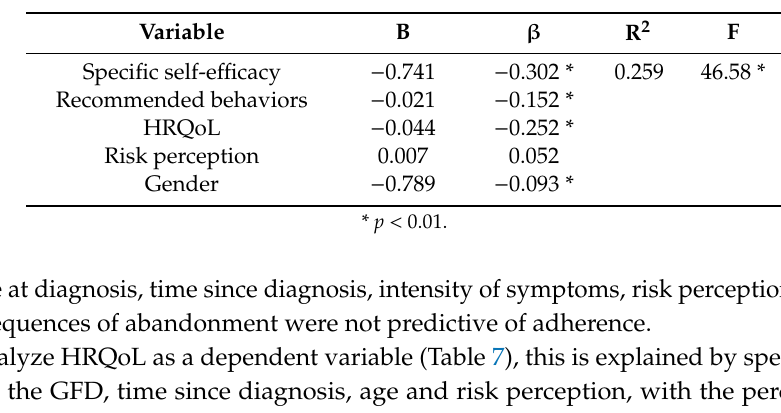
Table 6. Linear regression analysis predicting GFD